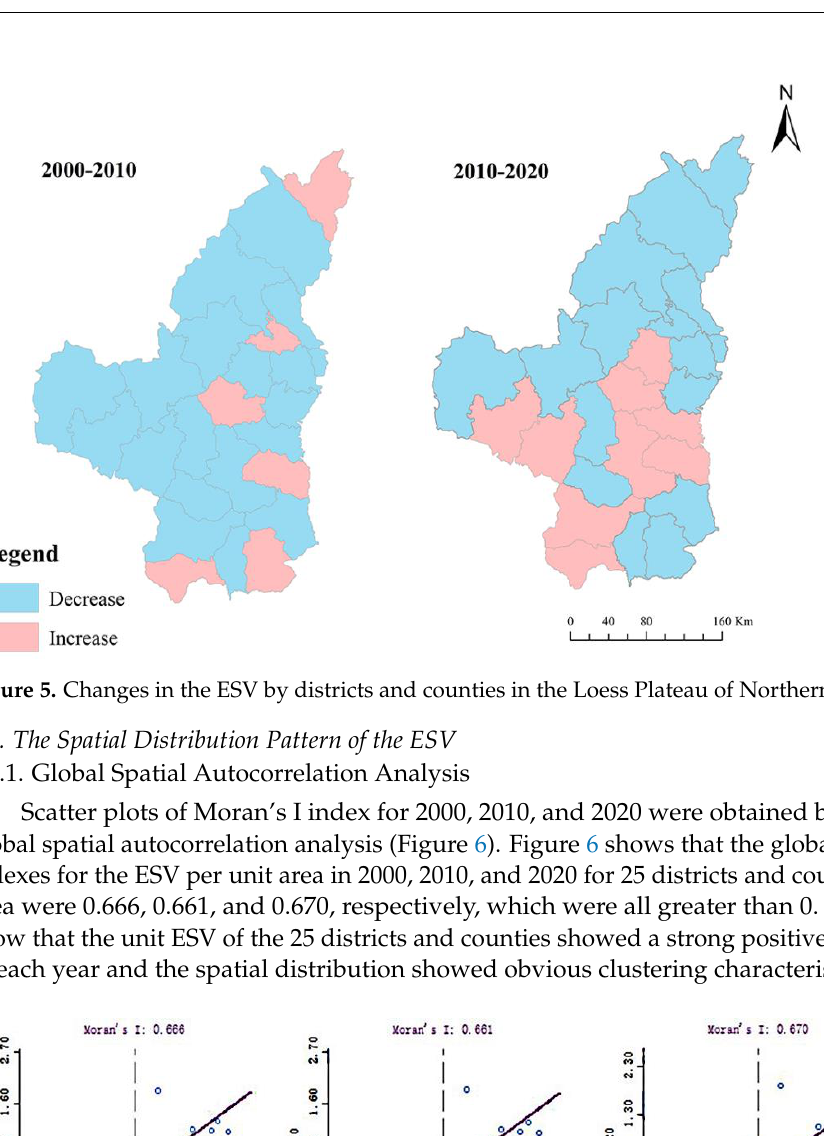
Figure 7. LISA aggregation map of the ESV per unit area in the 25 districts and counties in the Loess Plateau of Northern Shaanxi. Figure 7 shows that local spatial autocorrelation pattern of the ESV per unit area of the 25 districts and counties showed a “ high-high ” agglomeration area and a “ low-low ” agglomeration area. There was no “ high-low ” agglomeration area or “ low-high ” agglom- eration area. The “ high-high ” agglomeration area was distributed in the south of the study area, namely, Fuxian County, Luochuan County, Yichuan County, and so on. The unit ESV of these areas had a strong positive spatial correlation mechanism and improved the unit-area ESV of the surrounding area. The “ low-low ” agglomeration areas were primar- ily distributed in the central and northern areas of the study area, namely, Hengshan County, Jia County, Suide County, Zizhou County, etc., indicating that the ESV per unit